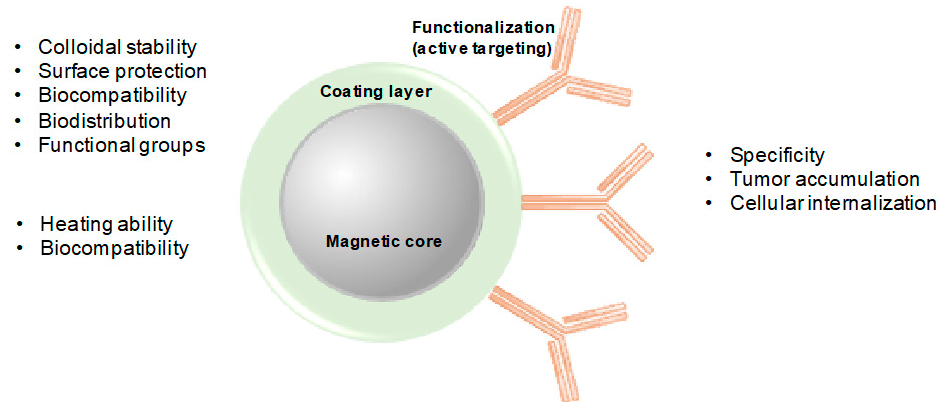
Figure 3. Simplified representation of a magnetic nanoparticle and its layers. Some of the factors a ff ected by each magnetic nanoparticle (MNP) layer in in vitro and in vivo context are highlighted in the respective color text box. the respective color text